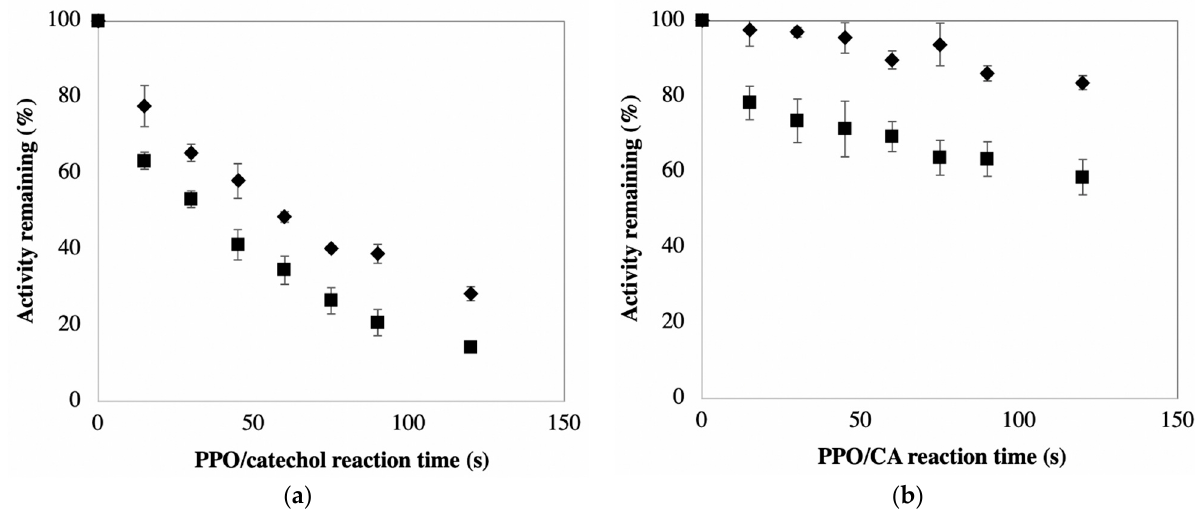
Figure 2. Effect of ascorbic acid (AA) on mechanism-based inactivation of PPO by catechol or CA. Semi-purified PPO was pre-incubated with 1 mM catechol ( a ) or 0.5 mM CA ( b ) in the absence ( ■ ) and presence ( ◆ ) of AA (2 mM for catechol and 4 mM for CA), in 50 mM sodium phosphate buffer, pH 7.0, for different periods of time. During pre-incubation time, vortexing of reaction mixtures with low speed was included to avoid O 2 limiting. The remaining PPO activity in the pre-incubation mixture was then measured by adding 0.1 mL pre-incubation mixture to 2.1 mL buffered CA solutions (final concentration 1 mM CA). Values are means ± standard deviations from triplicate assays.